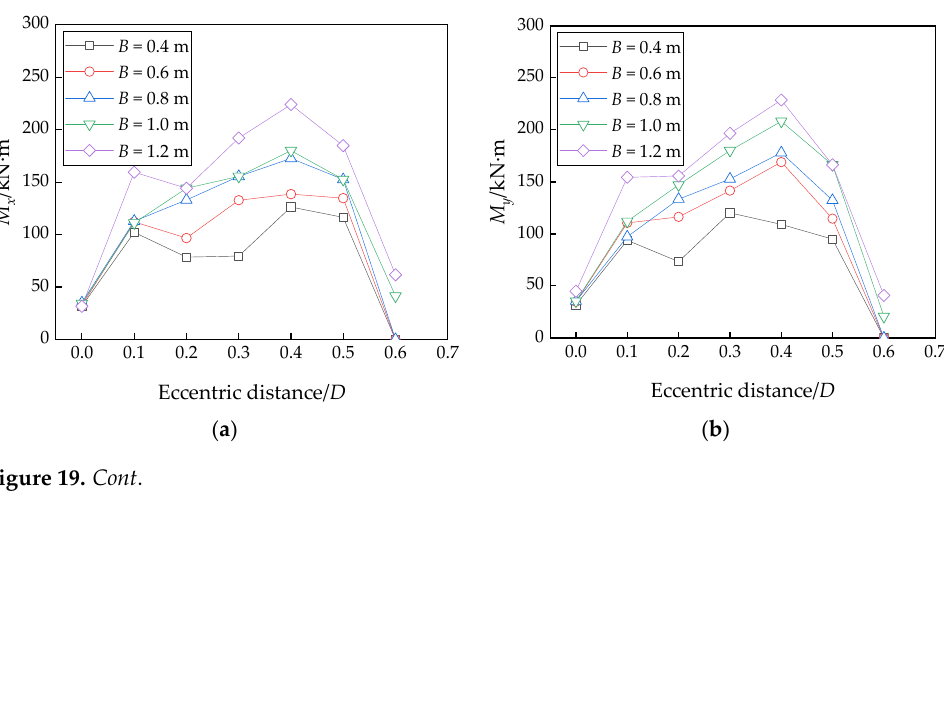
Figure 18. Effect of the eccentric distance e on the interaction forces: ( a ) F x ; ( b ) F y and ( c ) F z . Figure 19 presents the relation between interaction forces M x , M y , M z and cutting surface width B under different eccentric distances of 0, 0.1 D , 0.2 D , 0.4 D and 0.6 D . M x and M y generally show a similar trend of increasing first and then decreasing, and reaches a peak at about 0.3 D –0.4 D . They reach the peaks when the eccentric distance is about 0.3 D –0.4 D . This is the result of the combined effect of the change in the number of tools, the change in the force arm and the moments in different directions. The moments caused by the tools at the opposite sides of the cutter head (upper side and lower side for M x ; left side and right side for M y ) have different signs. Notably, the magnitude of M z is significantly larger than that of M z and M z . A reason is that the cutting force of tool is usually greater than the penetration force. Another reason is that all of the moments caused by cutting force of tools have the same sign. In addition, with the increase of eccentric distance, M z declines first, then increases, and decreases to 0 at last. The peak in the ascending interval appears at about 0.3 D –0.4 D . The main reason for this is the change in the number of tools involved.